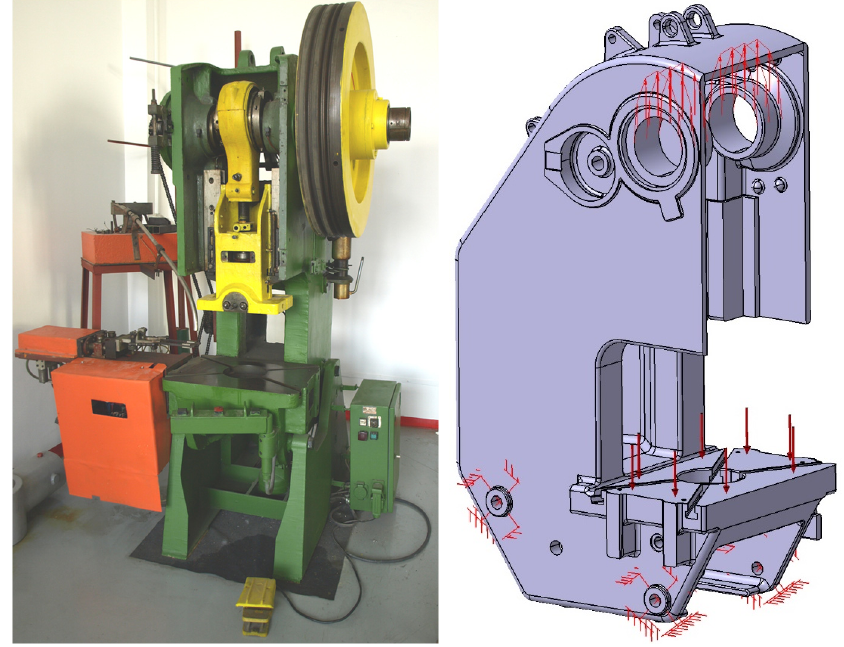
Figure 1. PAI 25 press and frame 3D model.